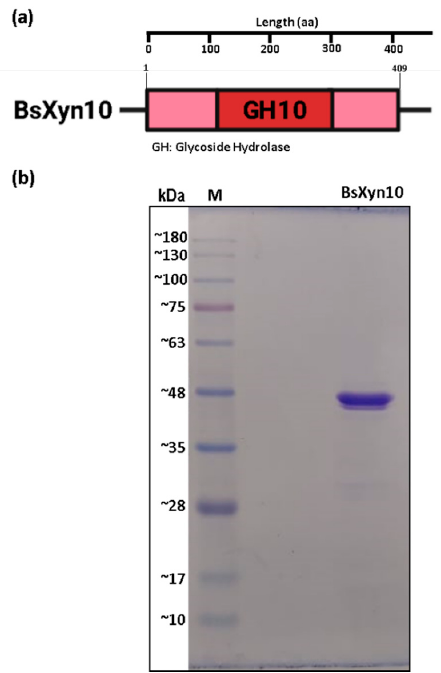
Figure 1. The identification and purification of BsXyn10. ( a ) Schematic domain architecture of BsXyn10. The full-length bsXyn10 encodes a 409-amino acid residue polypeptide (BsXyn10), only a GH10 catalytic module was detected in in BsXyn10. ( b ) The SDS-PAGE of purified BsXyn10. Lane M, protein molecular weight marker.